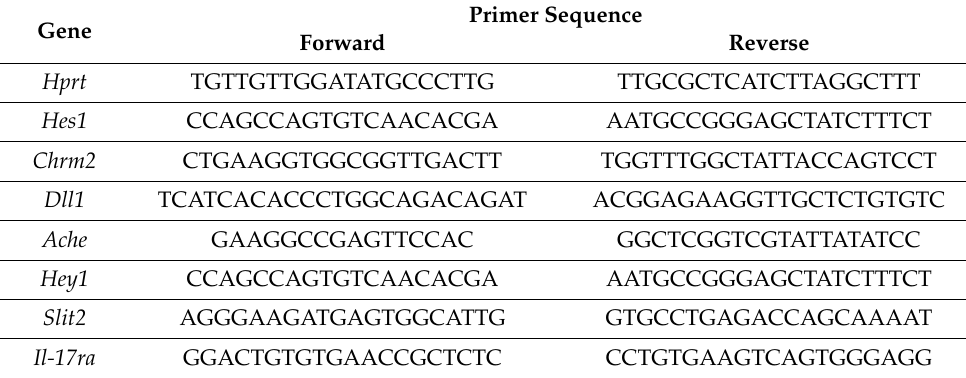
Table 1. Gene primer